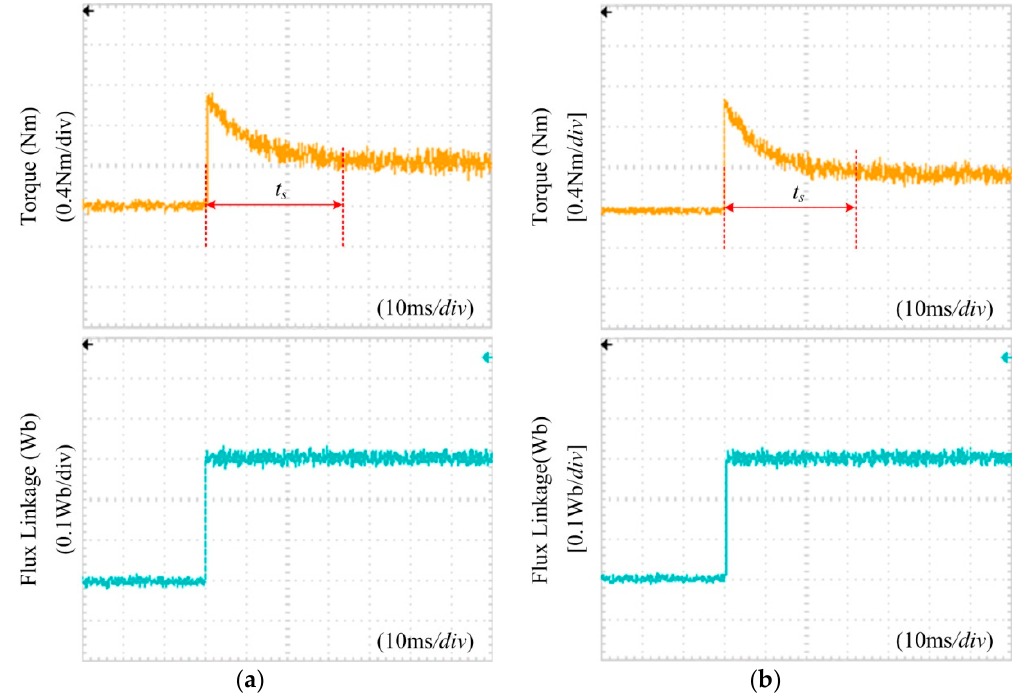
Figure 16. The torque and flux linkage trajectory when using: ( a ) NDTC; ( b ) FS-NDTC.